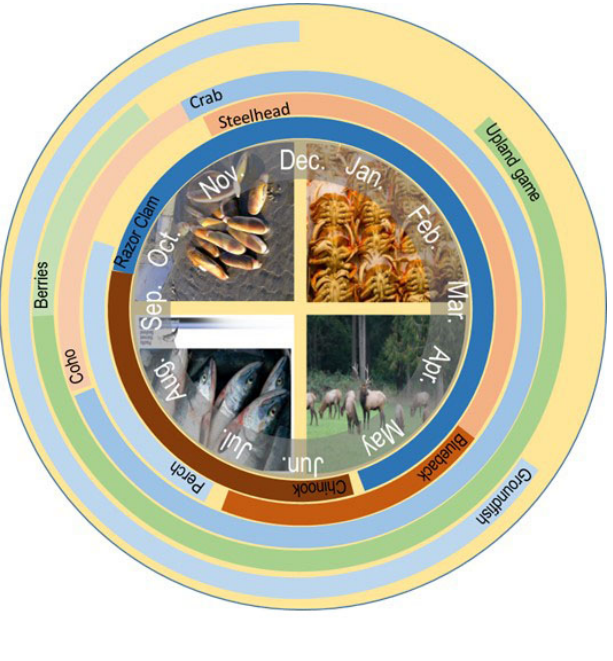
Fig. 3 . Seasonal cycle of the Quinault Indian Nation’s harvested food resources. The cycle highlights the availability of resources harvested for subsistence and commercial use and is based on interview